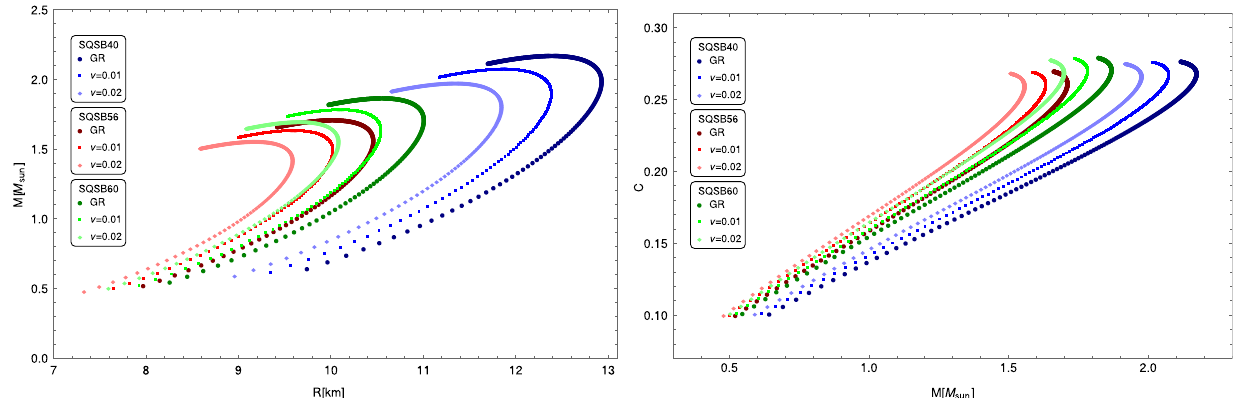
are also shown for comparison reasons. Left panel M R profiles (mass in solarmassesandradiusinkm).RightpanelCompactness C = G N M / R